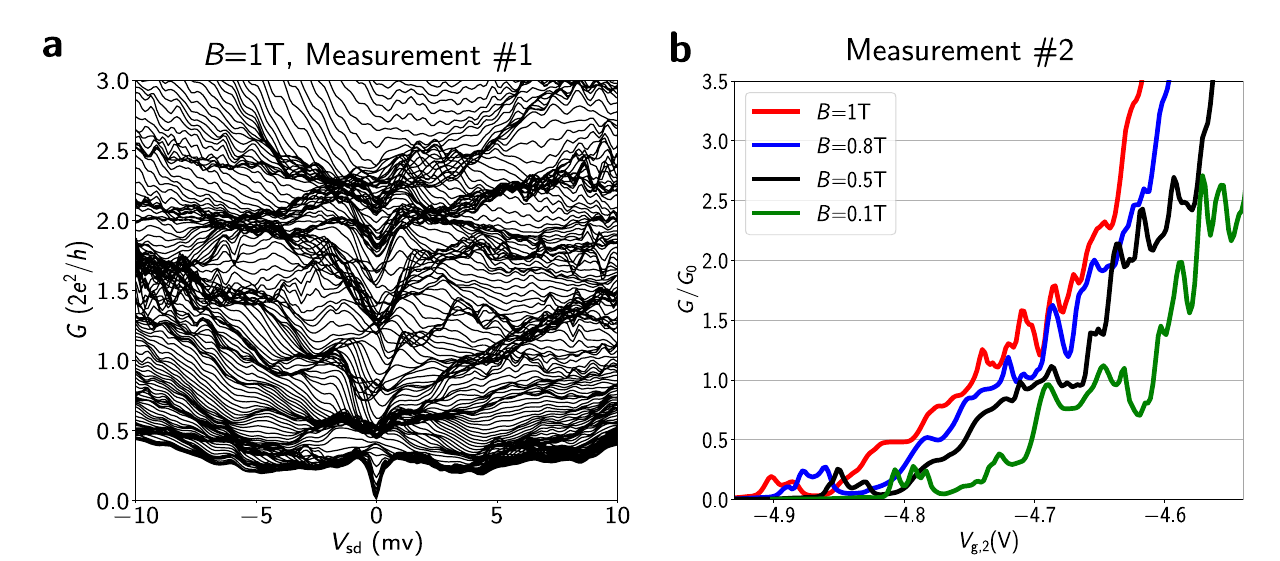
Fig. 5 | Zero-bias conductance measurements. a Waterfall plot of differential these measurements we have set V g,1 = − 6V and V g,3 = − 3V. The curves are offset conductance asa function of V sd for a range of gate voltagesfrom V g,2 = − 5.26V to on the gate voltage axis by 0.02V, 0.06V and 0.1V for B =0.8T, B =0.5T, and V B =0.1T, respectively for clarity. All measurements were taken at T − 5.5V with a step size δ V g,2 = g =1.3mV, for Device 3. b Zero-bias differential conductance for Device 3 for different values of out-of-plane magnetic fi eld. For